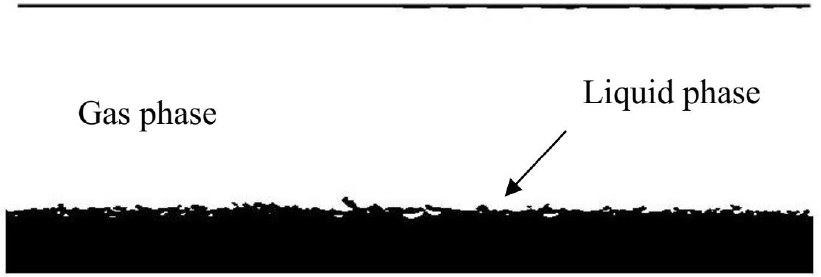
Figure 3. Image after image processing of stratified flow when the pressure is 0.2